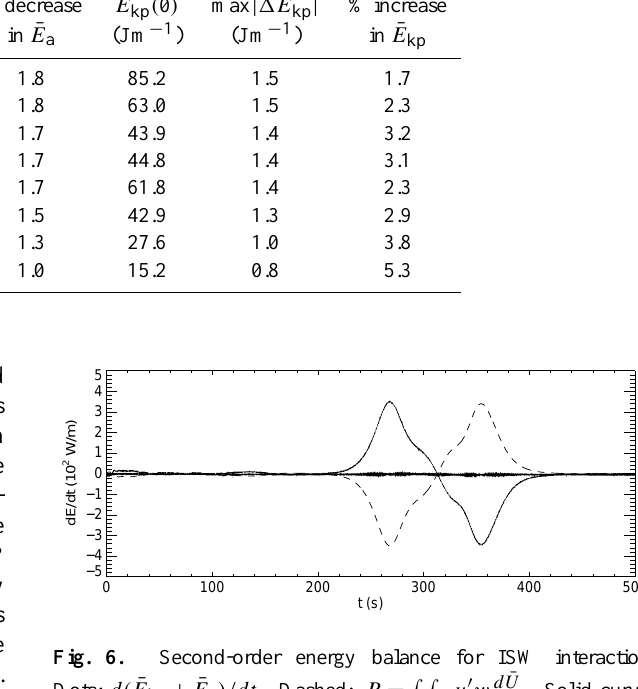
¯ U . Solid curve: dz